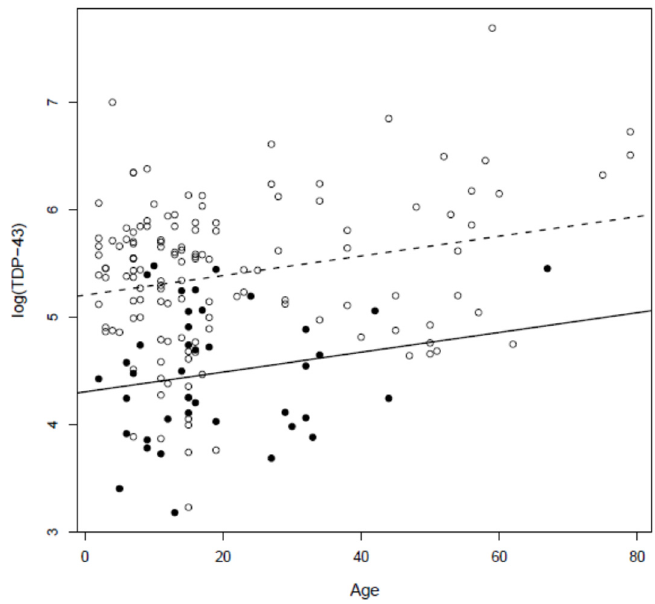
Figure 3. Linear regression of logarithm of TDP-43 CSF concentrations for age and residency (controls and MMC residents). Logarithm of TDP-43 increased significantly with age ( p = 0.0032). Black circles represent controls and open circles MMC residents.